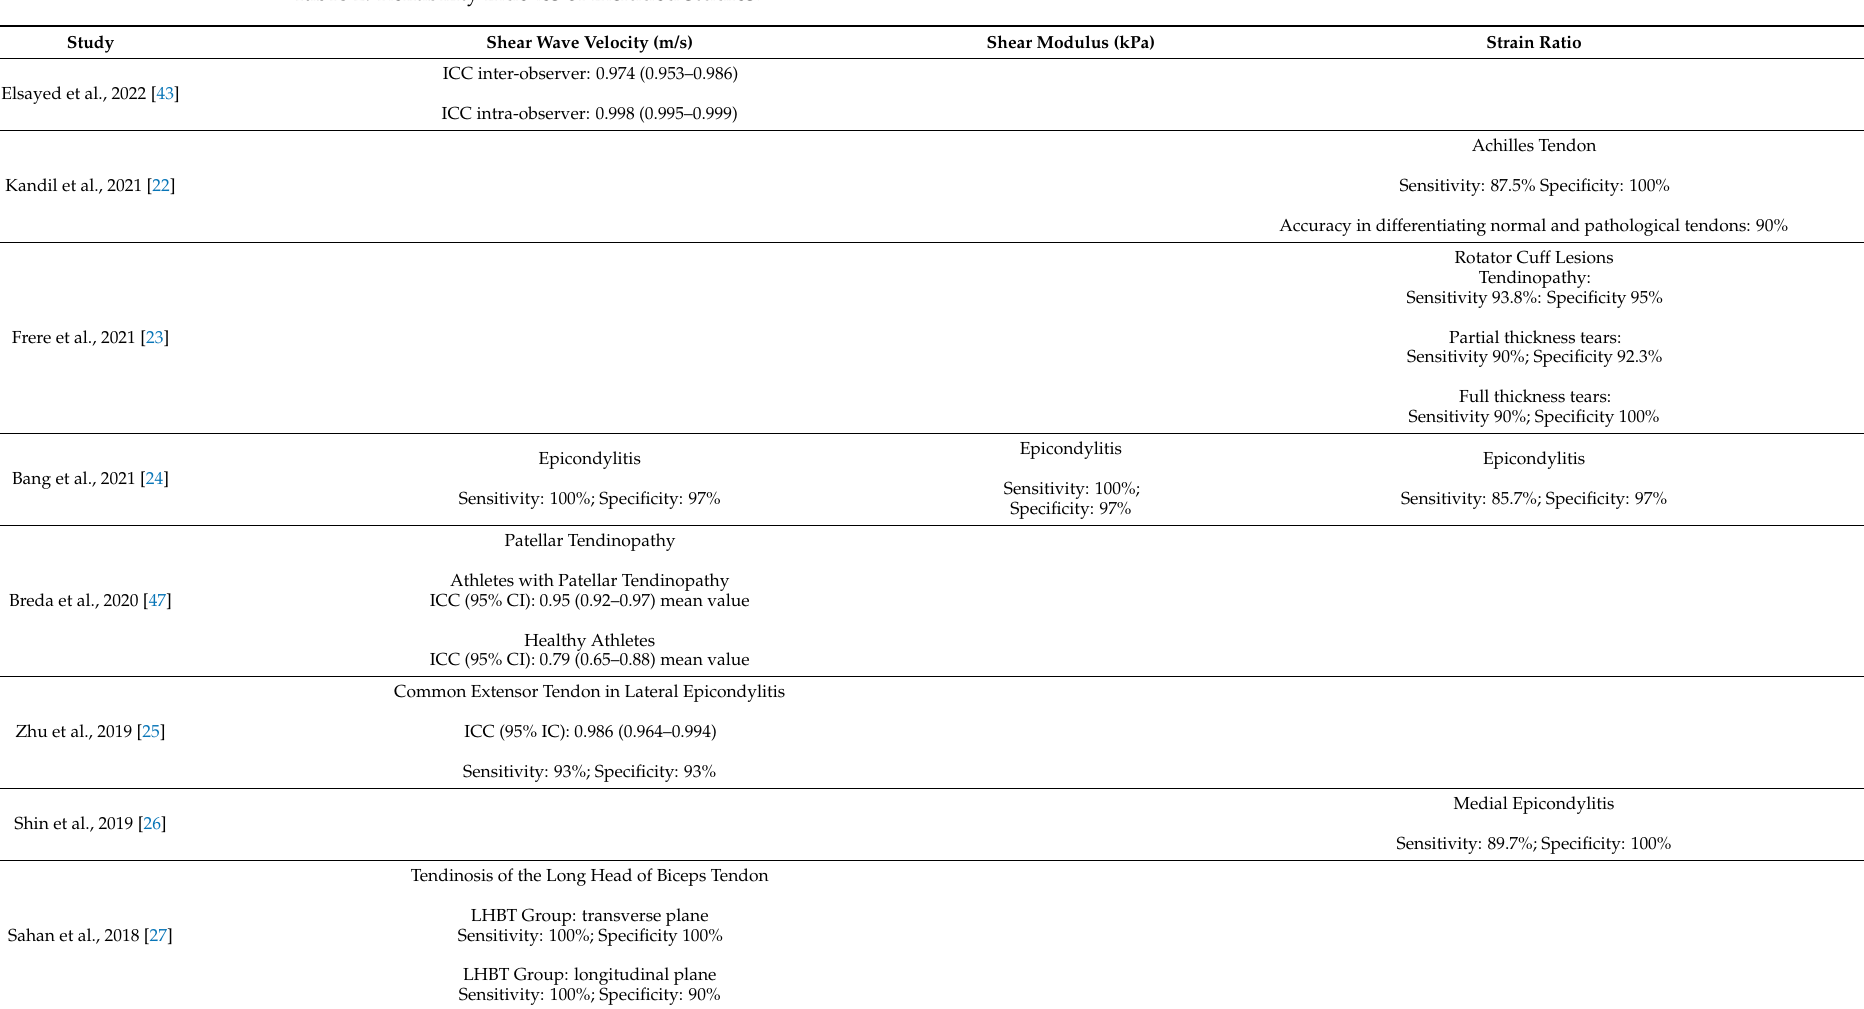
Table 2. Reliability indexes of included